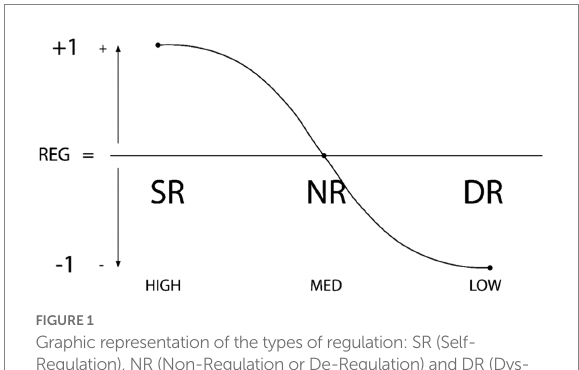
FIGURE 1 Graphic representation of the types of regulation: SR (Self- Regulation), NR (Non-Regulation or De-Regulation) and DR (Dys- Regulation). The degree of regulation (high-medium-low) is plotted on the x axis and the y axis shows positivity/negativity (+1, 0, − 1). The curved line shows the possible types of regulatory stages of a person and also the possible directionality of behavioral change.